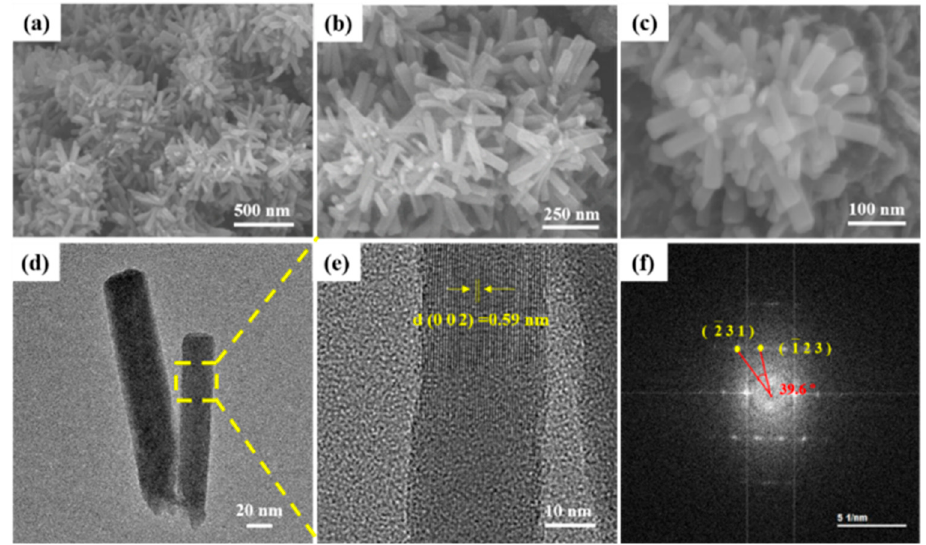
Figure 2. The morphology features and microstructures of VS 4 nanorods: ( a – c ) FESEM images with different magnifications; ( d ) TEM image; ( e ) HRTEM image of lattice spacing; ( f ) the fast-Fourier transform (FFT).